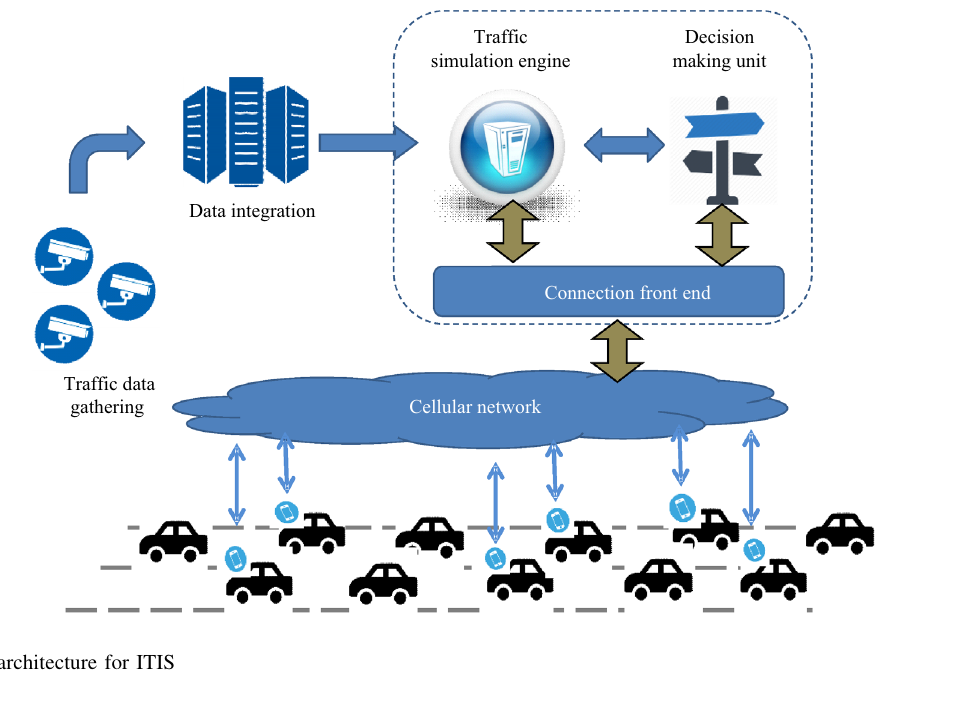
Table 3 Advantages and disadvantages of IDM in TSE